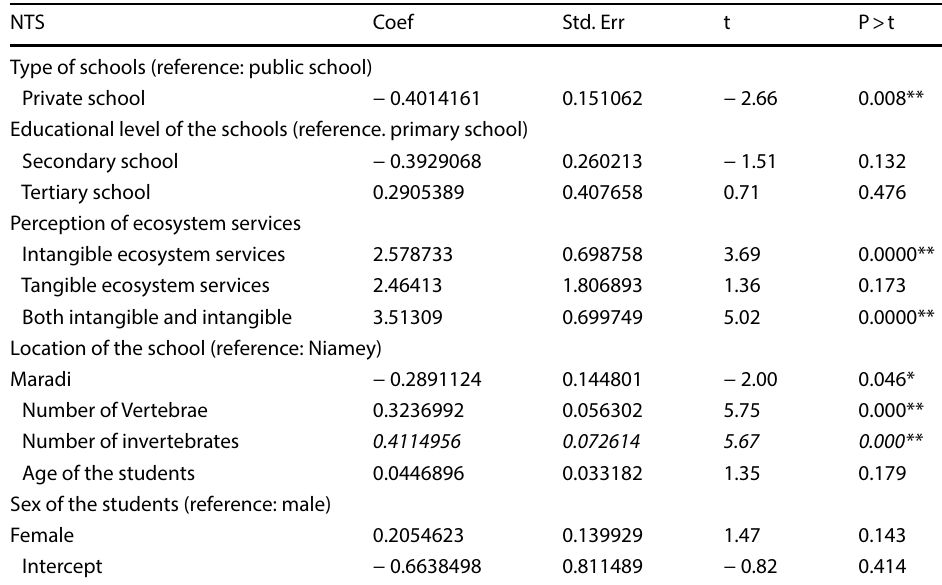
Table 6 Determinants of the students’ botanical knowledge of the tree species of the